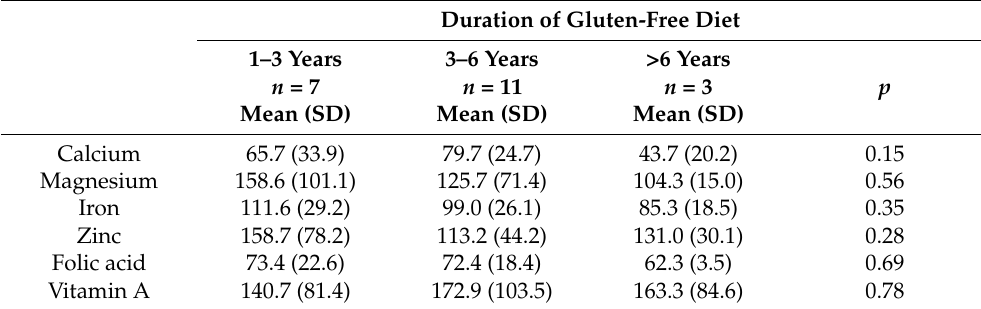
Table 11. Percentage of dietary reference intake (%DRI) for micronutrients in CD patients with regard to gluten-free diet